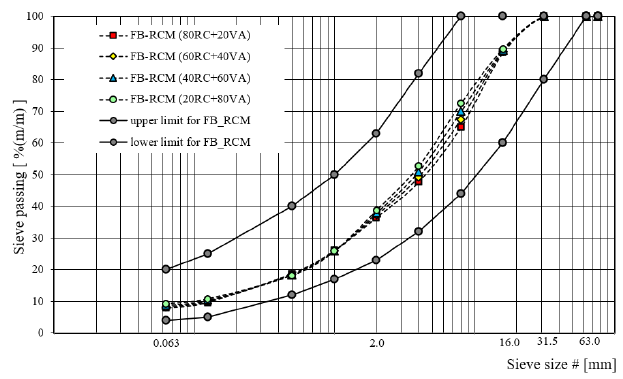
Figure 5. Gradation curve for FB-RCM with RC.